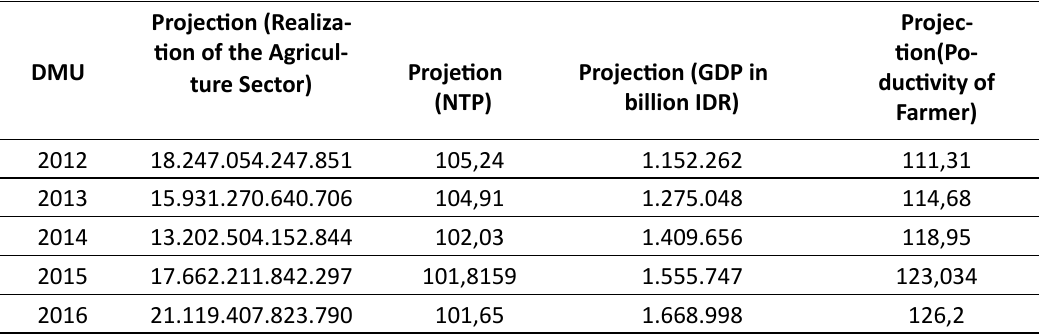
Table 3: Input Projection Needed 2015 (input oriented)